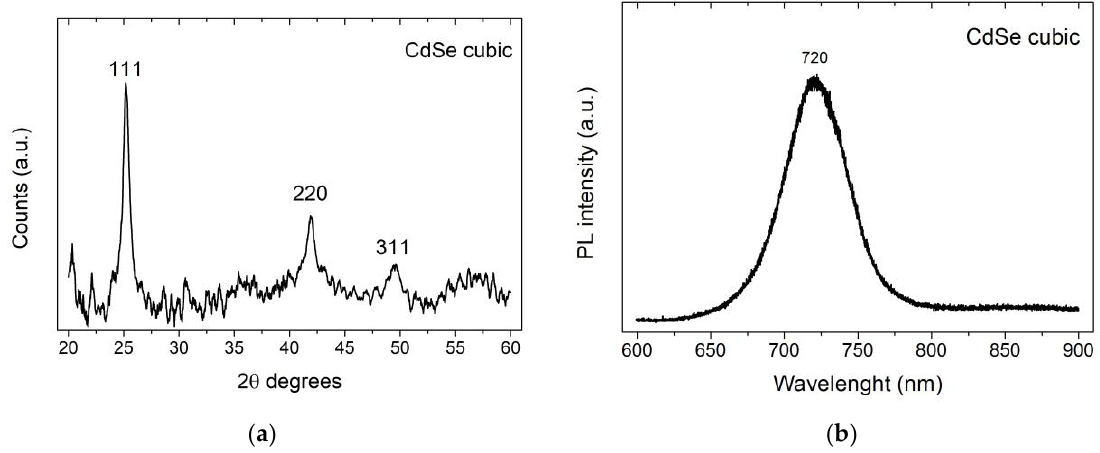
Figure 9. Spectroscopic analysis of sample E: ( a ) XRD analysis, coincides with the typical pattern of the zincblende form; ( b ) PL spectra, excited with a 561 nm laser, with the characteristic peak at 720 nm.